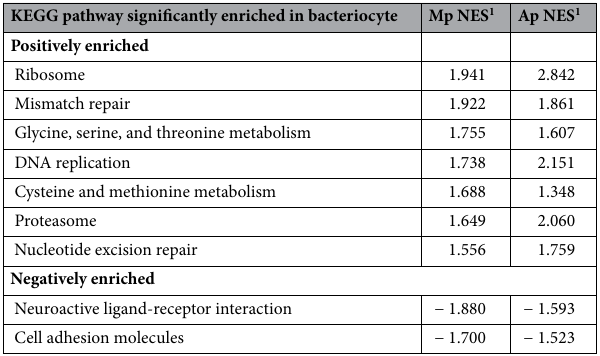
Table 3. GSEA analyses of both aphid species (Mp= M. persicae and Ap= A. pisum ) displaying all KEGG pathways that were significantly enriched in bacteriocytes compared to body for both species. 1 NES normalized enrichment score; Significance = the normalized p ≤ 0.05 and FDR q ≤